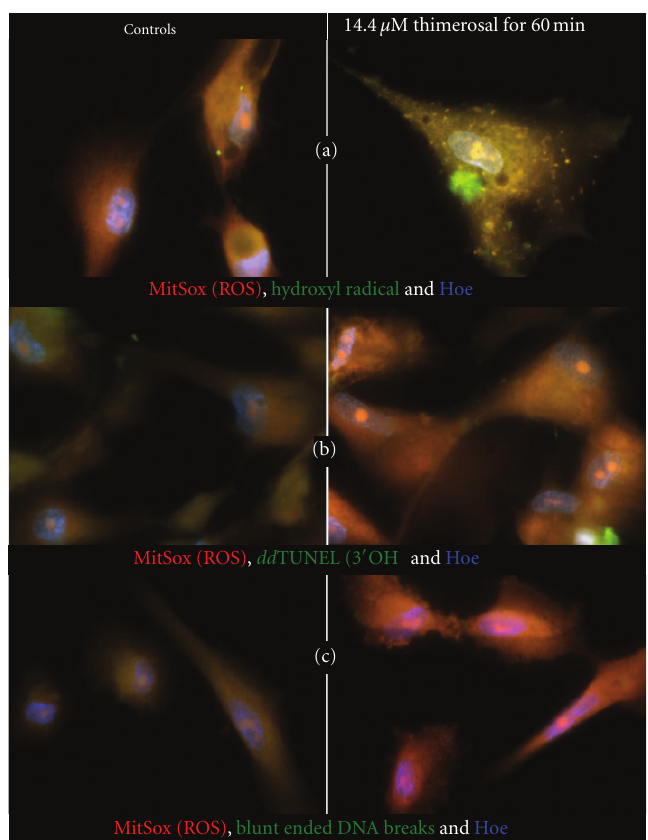
Figure 5: Mitochondrial superoxide production correlates with hydroxyl radical generation and mtDNA damage in normal human astrocytes. Thimerosal potentiates Fenton/Haber-Weiss chemistry in the mitochondrial matrix. Control NHAs and NHAs incubated for 1 hour with 14.4 µ M Thimerosal. Production of ROS measured with the mitochondrial superoxide probe MitoSox (red), and measurement of HO • via hydroxyphenyl fluorescein (HPF) (green) in (a), 3 (cid:3) OH DNA ends with dd TUNEL (green) in (b), and blunt-ended DNA breaks (green) in